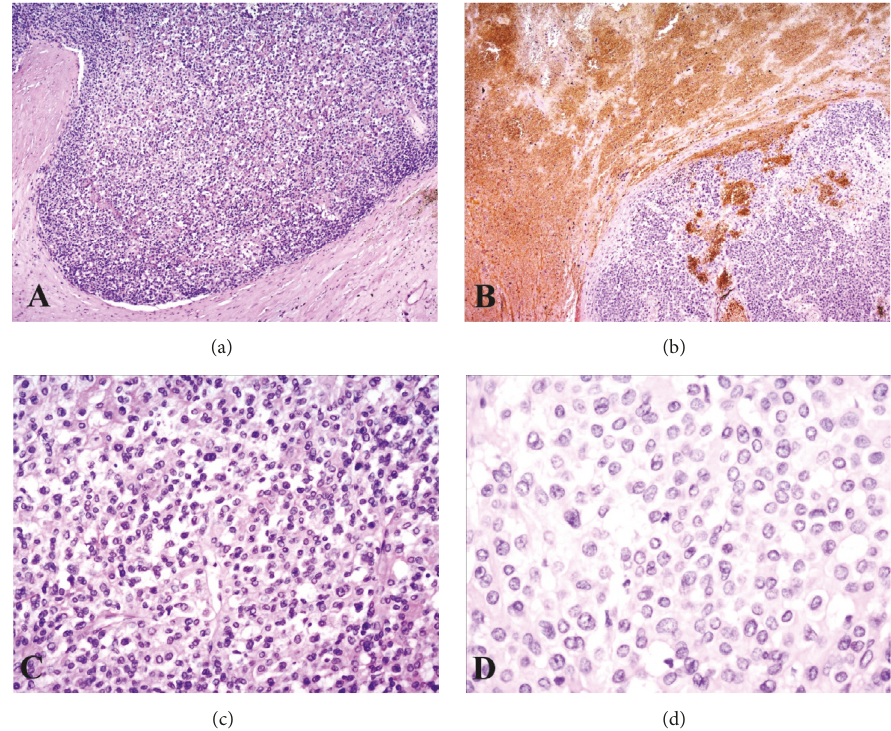
Figure4:Microscopicfindingsofthetumor.(a)Tumorcellsgrowinasolidsheet.(b)Hemorrhagewasmarked.(c)Tumorcellshaverelatively bland nuclei and clear to eosinophilic cytoplasm. Cell border is indistinct. (d) Mitosis is observed (hematoxylin & eosin staining, (a, b): x5, (c): x20, (d):